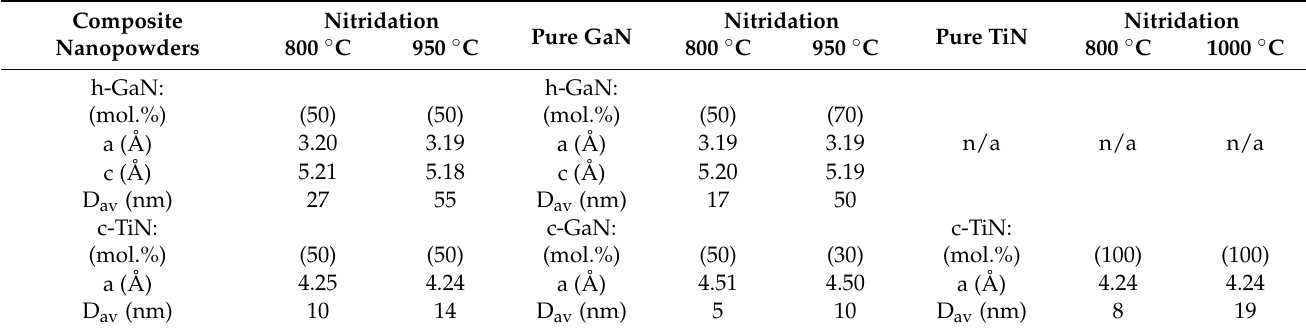
Composite Nanopowders